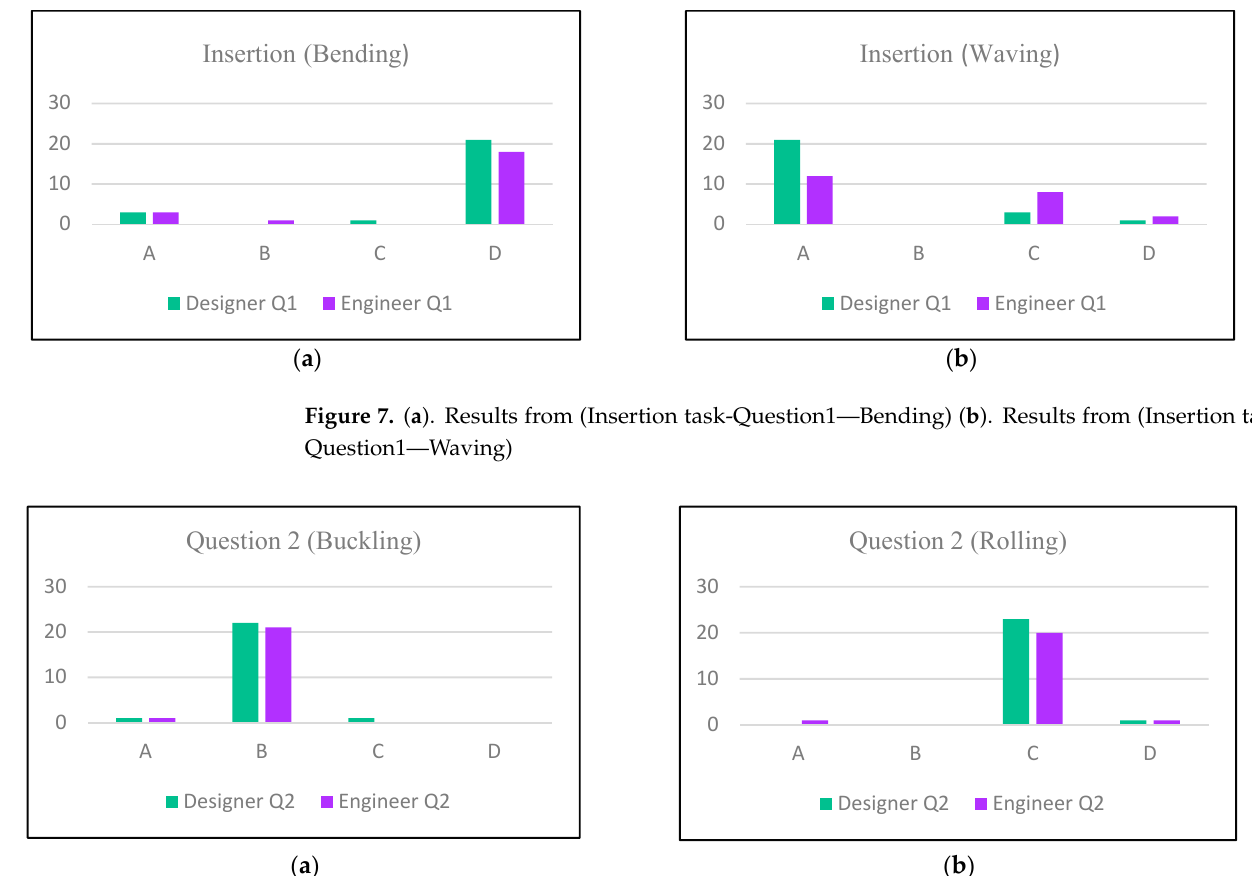
Figure 8. ( a ). Results from (Insertion task- Question2—Buckling) ( b ). Results from (Insertion task-